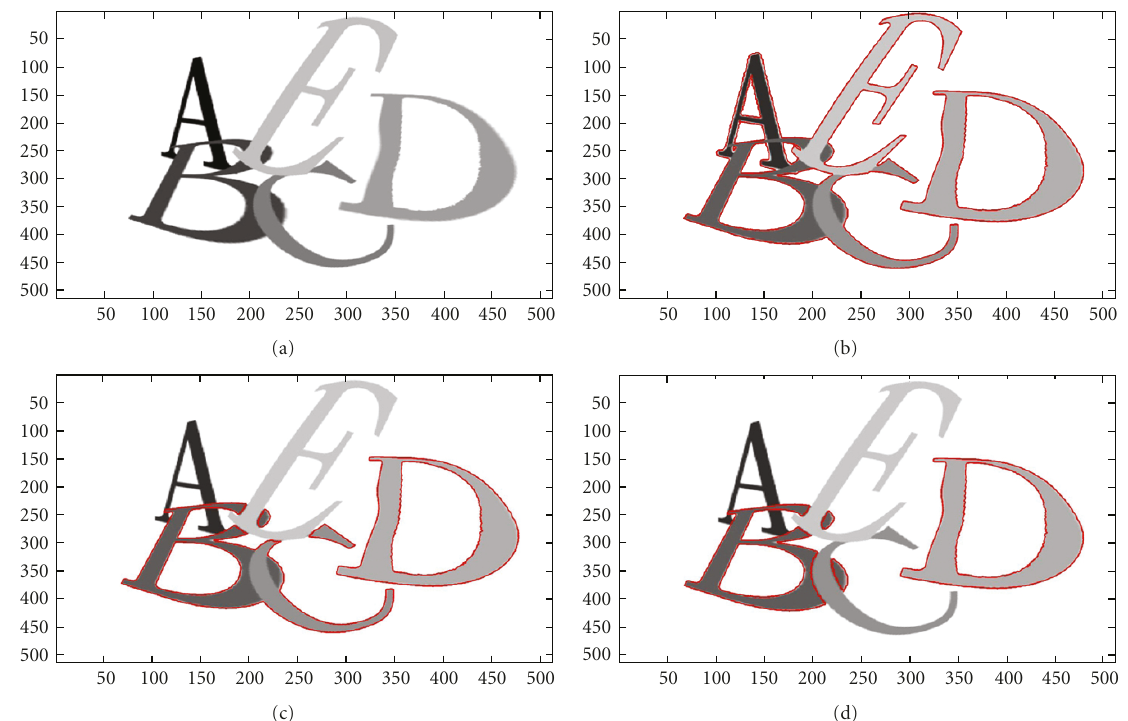
Figure 6: (a) Original image and segmentation result obtained by (b) level set method, (c) threshold level set method, and (d) multi- threshold level set